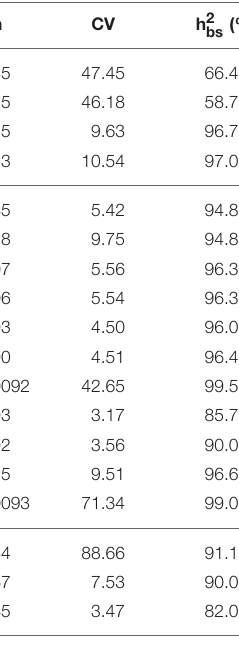
TABLE 2 | Phenotypic variation of 18 traits analyzed in the complete collection. Category Trait Yield